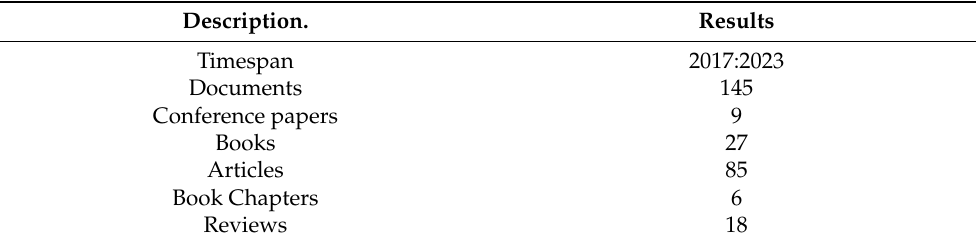
Table 2. Distribution of the characteristics of the data.